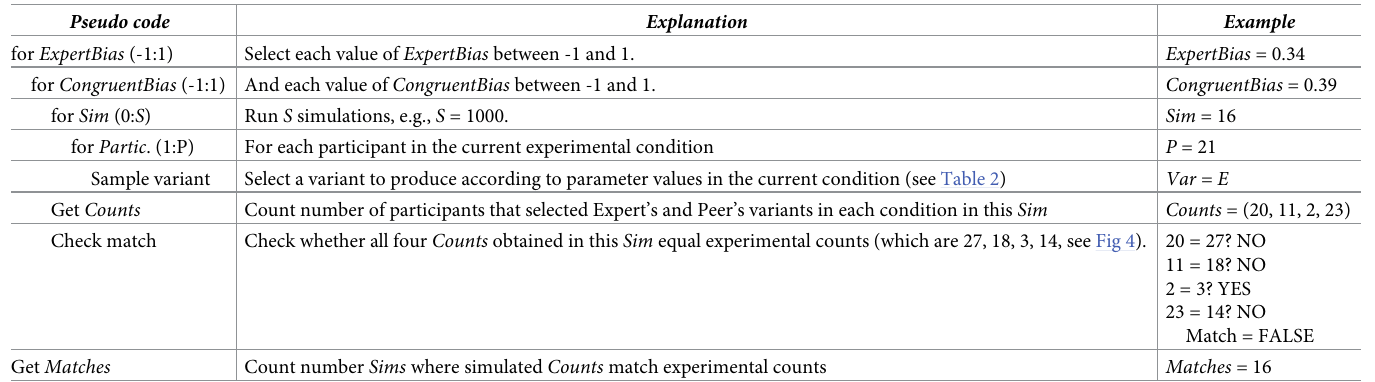
Table 1. Description of each step of the simulation. Pseudo code